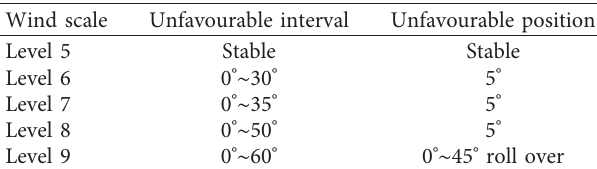
Table 8: Data under level 5–9 wind